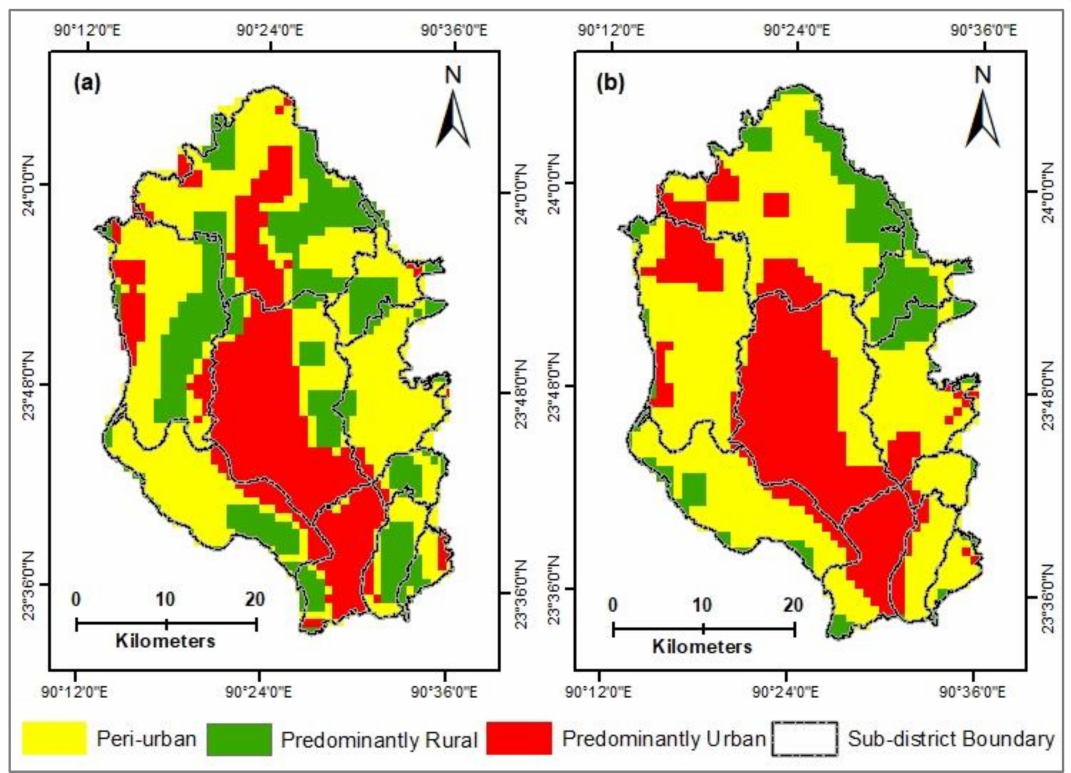
Figure 8. ( a ) Peri-urban mapping of 1992; ( b ) peri-urban mapping of